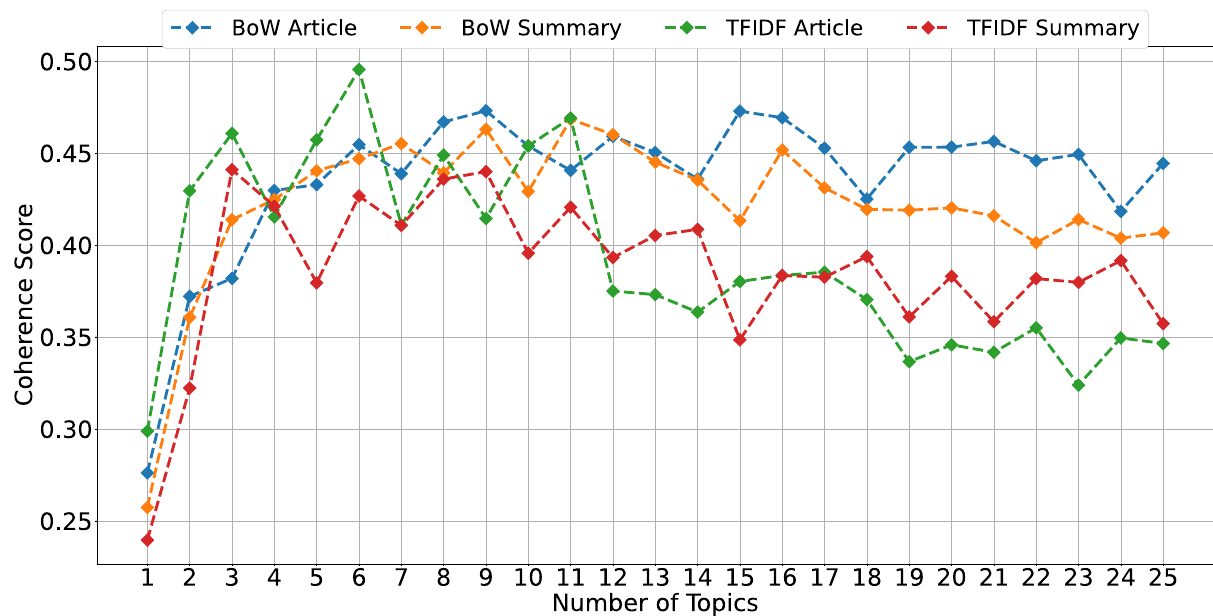
Fig 2. Illustrating the coherence score for different number of topics for bag of words and TF-IDF models employed on article and summary.